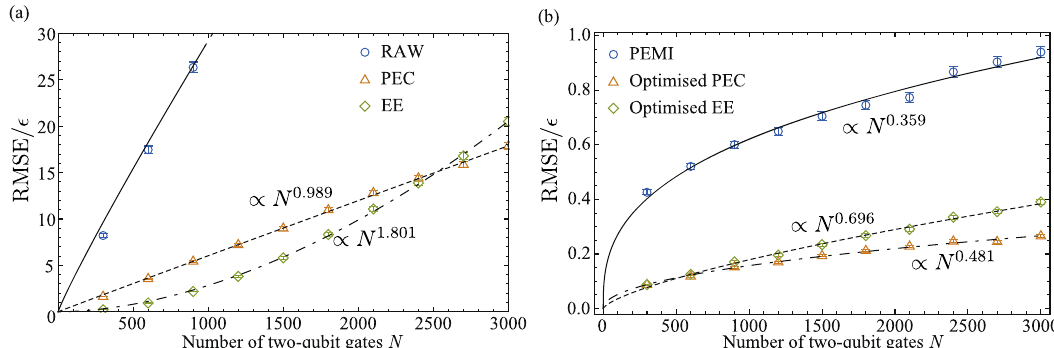
Fig. 9 Root mean square errors (RMSE) in error mitigation protocols. The result is obtained using ten-qubit periodic-cycling circuits under the error model in Eq. (36) with ϵ d = 8 × 10 − 5 and ϵ z = 2 × 10 − 5 , and we use 1000 Clifford circuits generated via Algorithm 2 for the training and 1000 unitary circuits to compute the RMSE. The error bar represents one standard deviation. In the raw result without error mitigation, RMSE increases linearly with the gate number. In error extrapolation (EE), noise is increased imperfectly: ϵ d = 1.8 × 10 − 4 and ϵ z = 2 × 10 − 5 in the error model with a doubled error rate, i.e. only the gate depolarising component is increased. In probabilistic error cancellation (PEC), we take the inverse map in Eq. (37) according to an inaccurate error model with only gate depolarising errors, i.e. we take λ = − 16 ϵ d /(15 − 16 ϵ d ) before the optimisation and the optimal value after the optimisation.